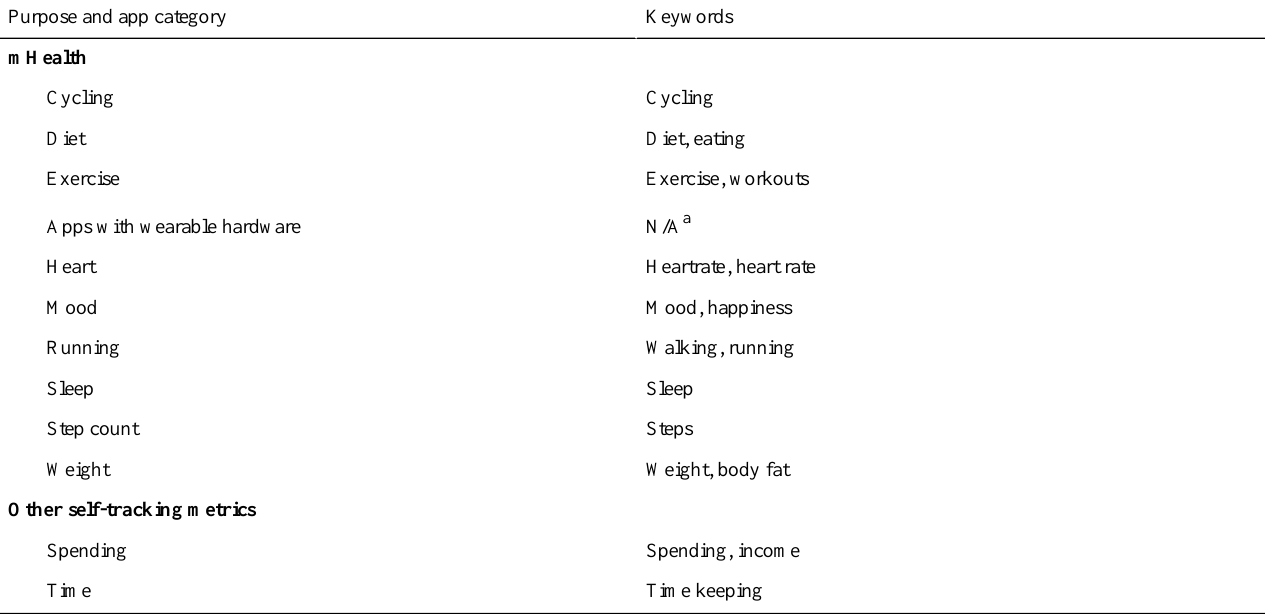
Table 2. The categories of apps used in our evaluation and the constituent search keywords for each group. KeywordsPurpose and app